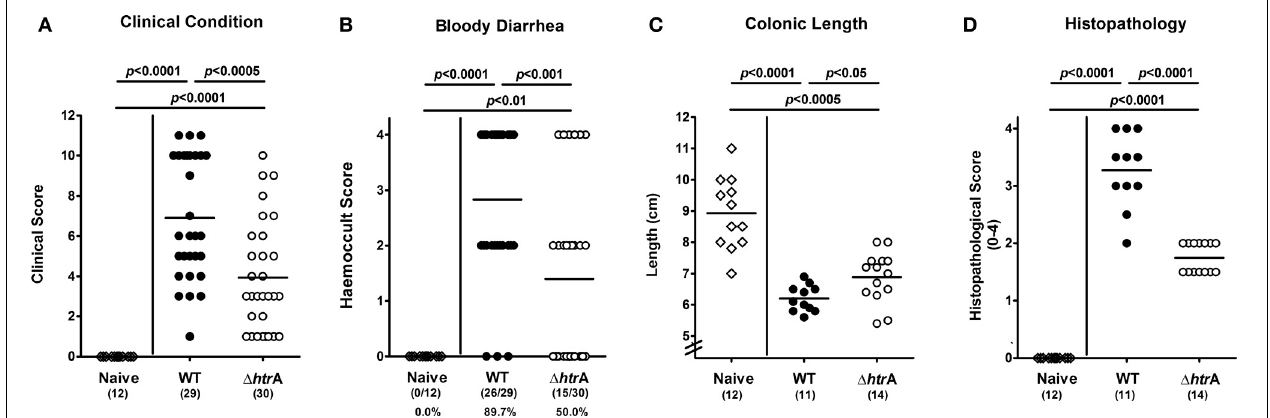
FIGURE 2 | Role of C. jejuni htrA gene in acute enterocolitis following infection of gnotobiotic IL-10 − / − mice. Six days following C. jejuni infection (A) disease activity and (B) occurrence of blood in fecal samples was assessed by applying respective standardized clinical scoring system. Furthermore, (C) large intestinal lengths (in cm) were measured and (D) histopathological changes applying a standardized histopathological score in